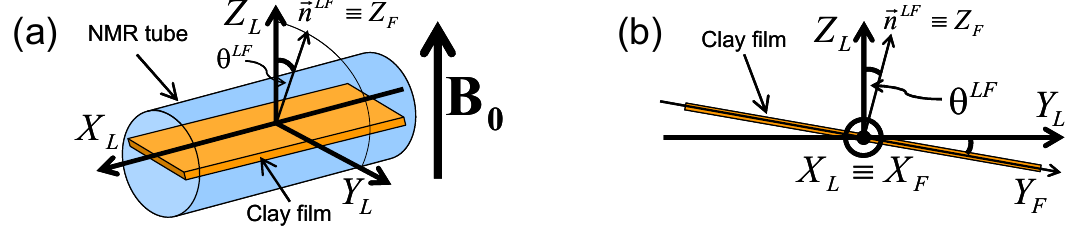
Figure 3. Schematic view of: ( a ) the film orientation within the NMR tube used to insert the clay film sample into the detection coil (see the text); and ( b ) the different Euler angles characterizing the orientation of the clay film by reference to the static magnetic field B 0 . Reprinted with permission from [53]. Copyright (2014) American Chemical